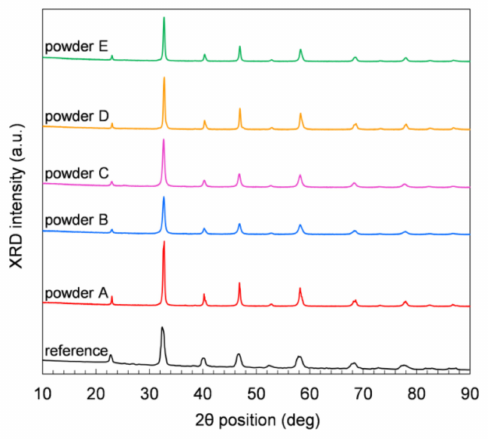
Figure 3. XRD patterns of the LSCF powders measured at room